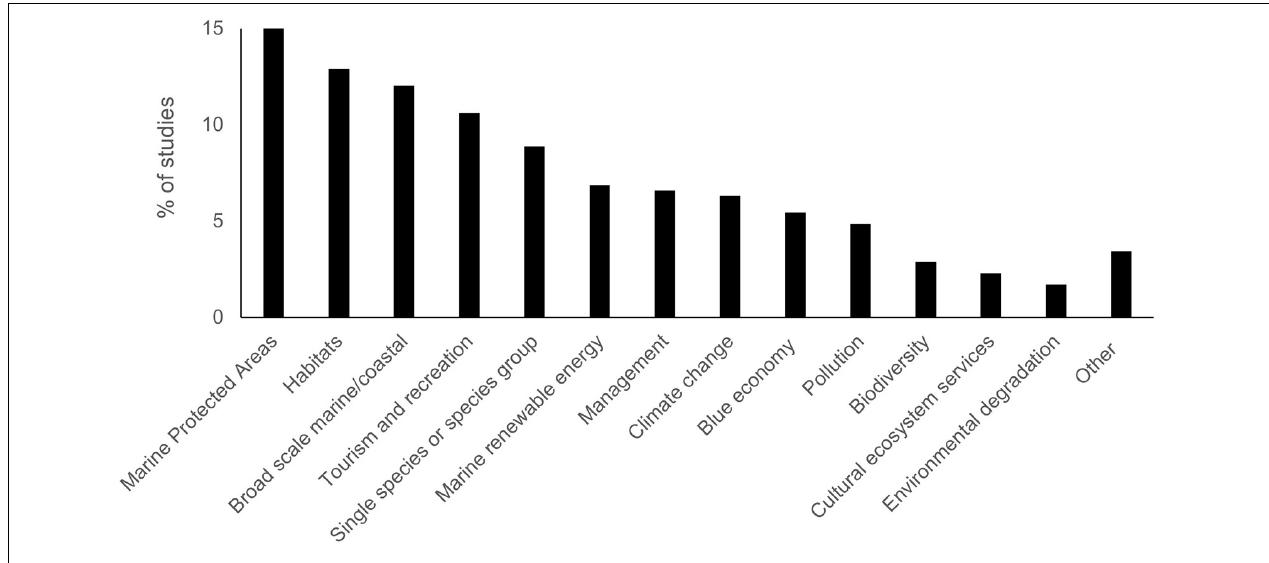
FIGURE 3 | Percentage of ocean perceptions studies investigating each theme; studies were allocated to a single category ( n =